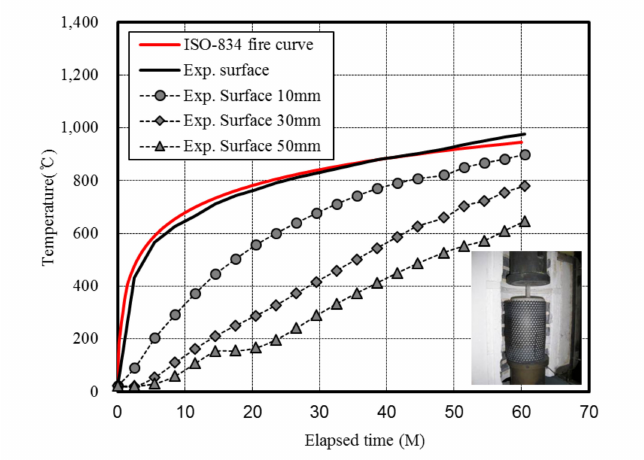
Figure 5. ISO-834 fire curve and inner temperature histories of the concrete specimen.